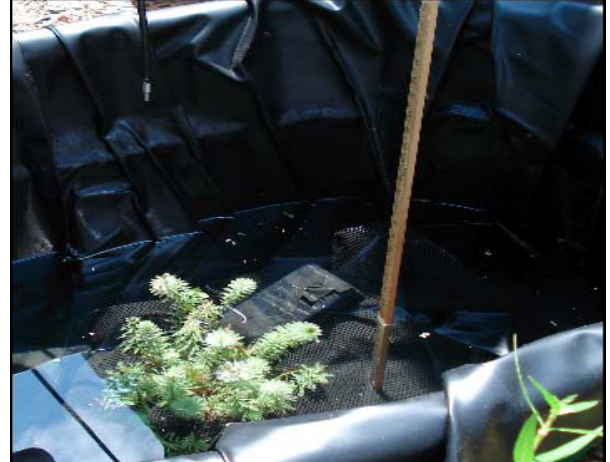
Figure 2 : The mixture of submerged aquatic vegetation (SAV) deployed at the bottom of the experimental tank. To obtain the depth-induced variations in the spectral responses of SAV, a mixture of M. aquaticum, C. demersum and C.caroliniana was threaded through a black mesh sheet and fixed on the bottom of a black-lined tank. The plants were planted at a density similar to the mean natural density during the local growing season. The inside of the tanks were lined with black plastic pond liners to eliminate reflectance from the interior